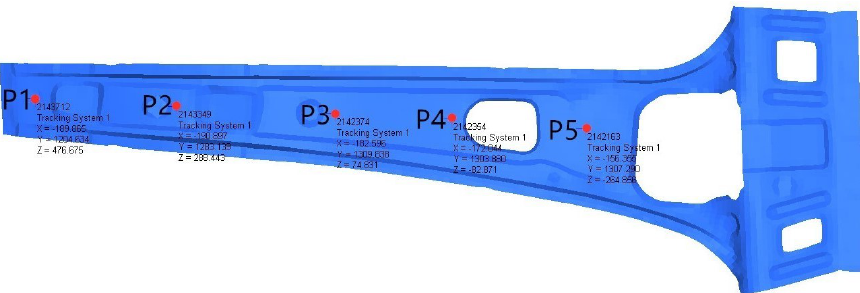
Figure 6. Horizontal layout of the B-pillar inner